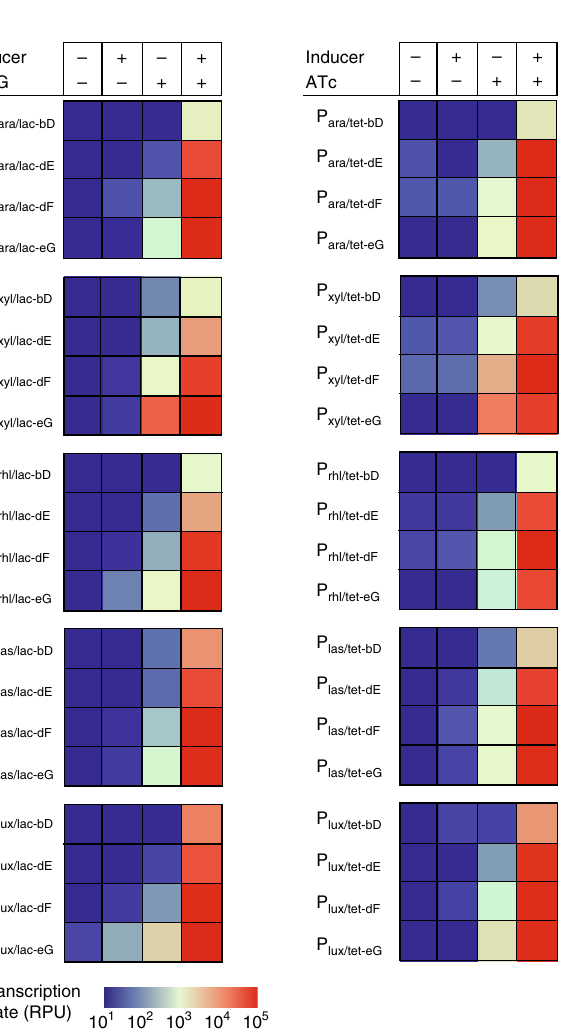
Fig. 5 Combinations of − 10 and − 35 sites with large dynamic ranges are compatible with diverse regulatory sequences. a Experimentally measured transcription rates of a collection of engineered two-input hybrid promoters that use the dE, dF, bD, or eG combination of − 10 and − 35 sites. The promoters contain operator sites for one of the fi ve different transcriptional activators (AraC, XylR, RhlR, LasR, or LuxR) and one of the two transcriptional repressors (LacI or TetR). Each promoter was tested in all four possible combinations of inducers for its respective activator and repressor. The AND gate is considered well behaved if the promoter is active only in the presence of both inducers. b Experimentally measured transcription rates of a collection of engineered three-input hybrid promoters that use the dE, dF, bD, or eG combination of − 10 and − 35 sites. These promoters contain operator sites for one of the fi ve different activators (AraC, XylR, RhlR, LasR, or LuxR) and the operator sites for both LacI and TetR. Each promoter was tested in all eight possible combinations of inducers for its respective activator and repressor. Transcription should occur if and only if the inducers for all three transcription factors are present. Experiments were performed with biological triplicates. Experimental data for negative controls are available in the Supplementary